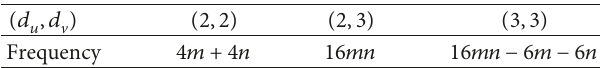
Table 3: Edge partition of the benzene ring embedded in the P-type surface network based on degrees of end vertices of each edge.